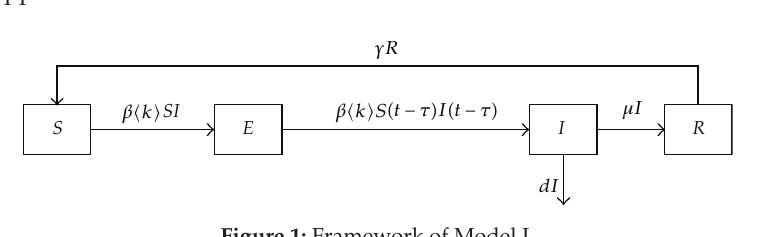
Figure 1: Framework of Model